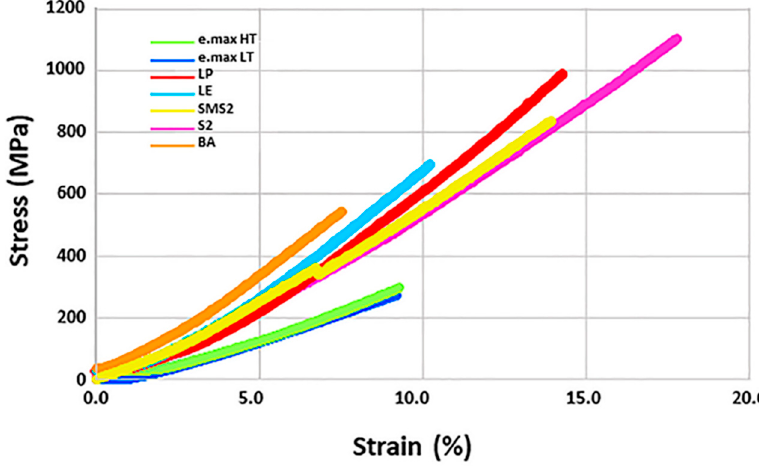
Figure 5. Stress-strain curves. S2 showed the highest ductility.